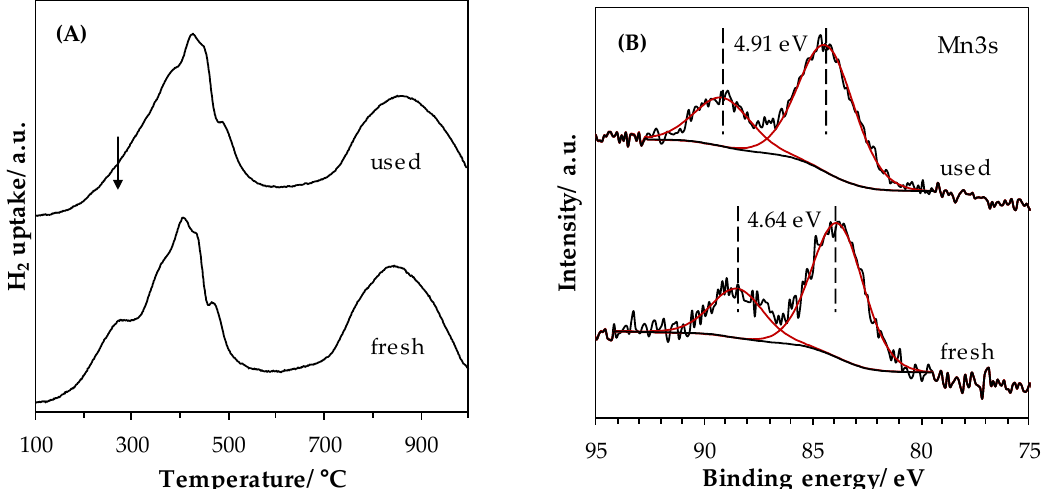
Figure 11. Comparison of ( A ) H 2 -TPR profiles and ( B ) XPS high resolution spectra of Mn3s obtained for the fresh and used LaMn_LEBM catalysts.